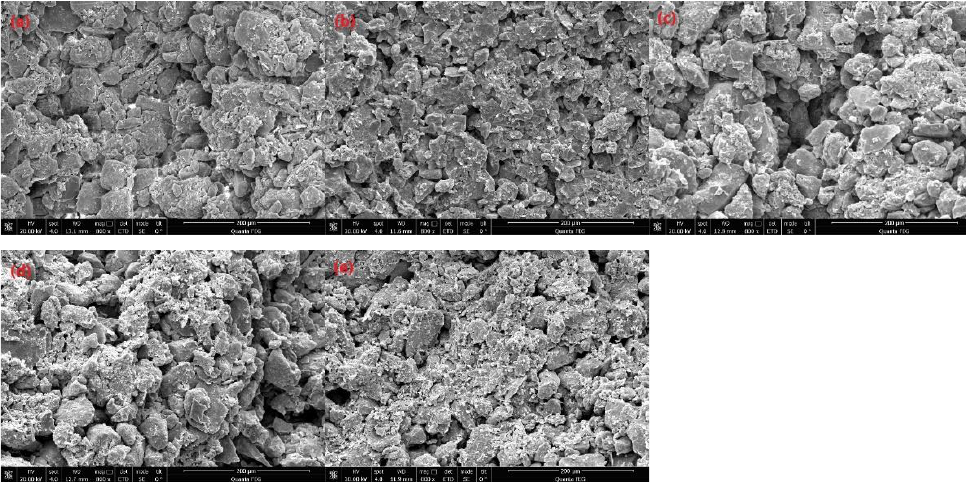
Figure 7. SEM photographs of remolded loess specimens at different creep stages: ( a ) before test; ( b ) decay creep; ( c ) steady creep; ( d ) before creep test; ( e ) after creep test.